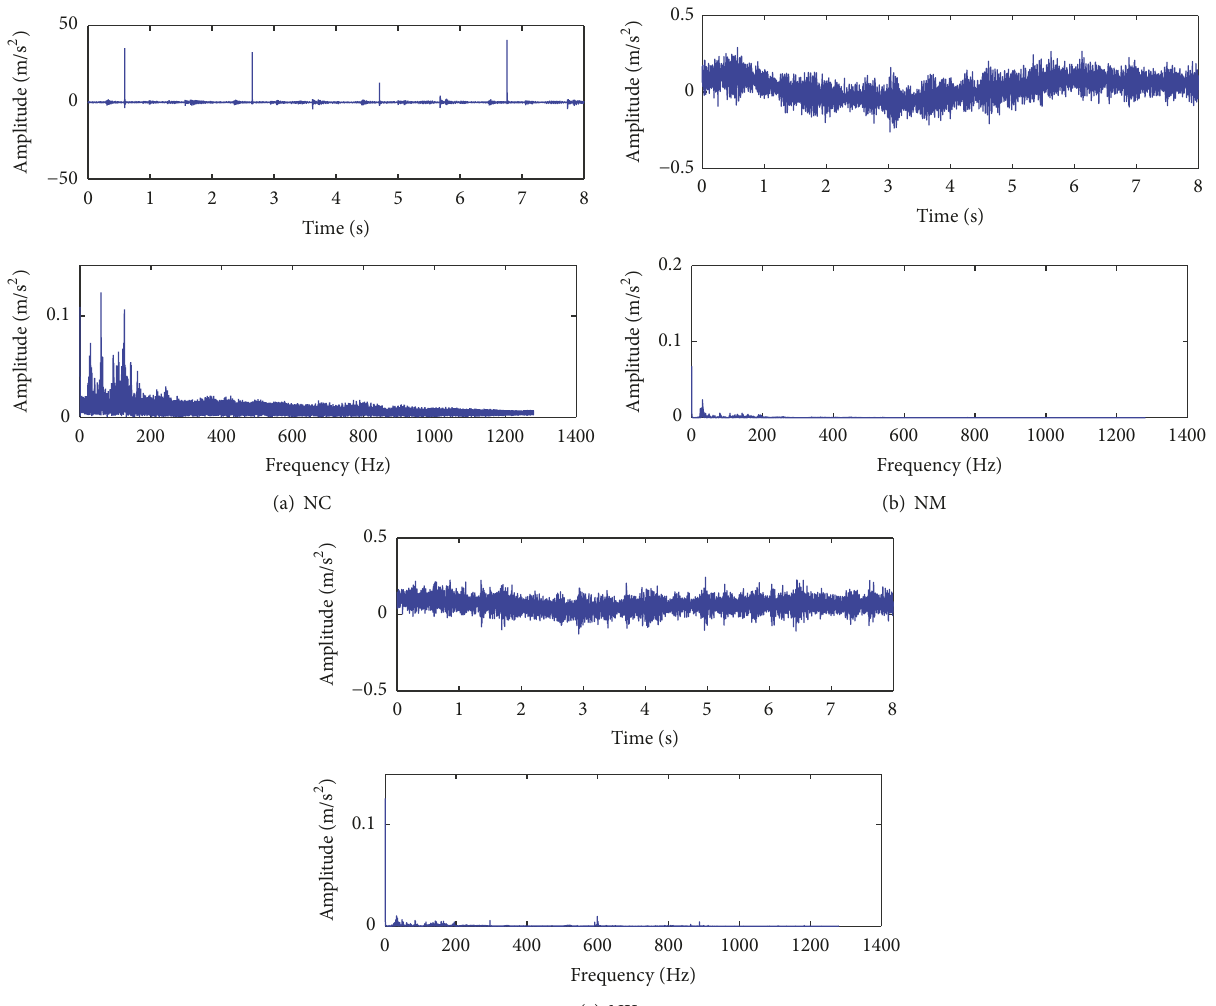
Figure 5: The analysis results of time domain and frequency domain for different work